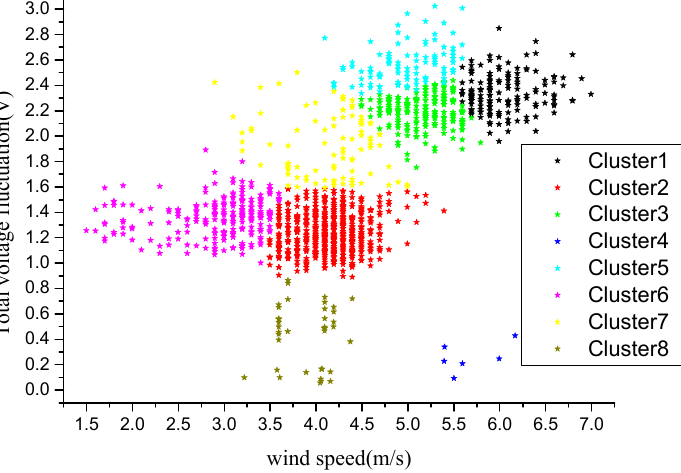
Figure 10. Clustering result with 1500 data segments (k = 8).